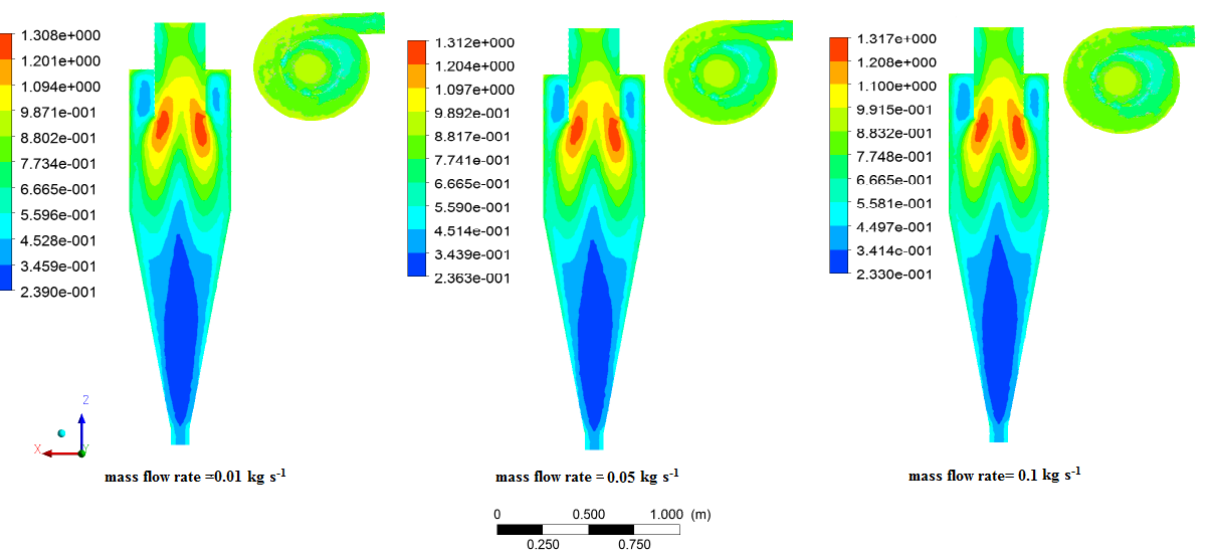
Figure 14. Turbulent intensity contours in various mass flow rates.